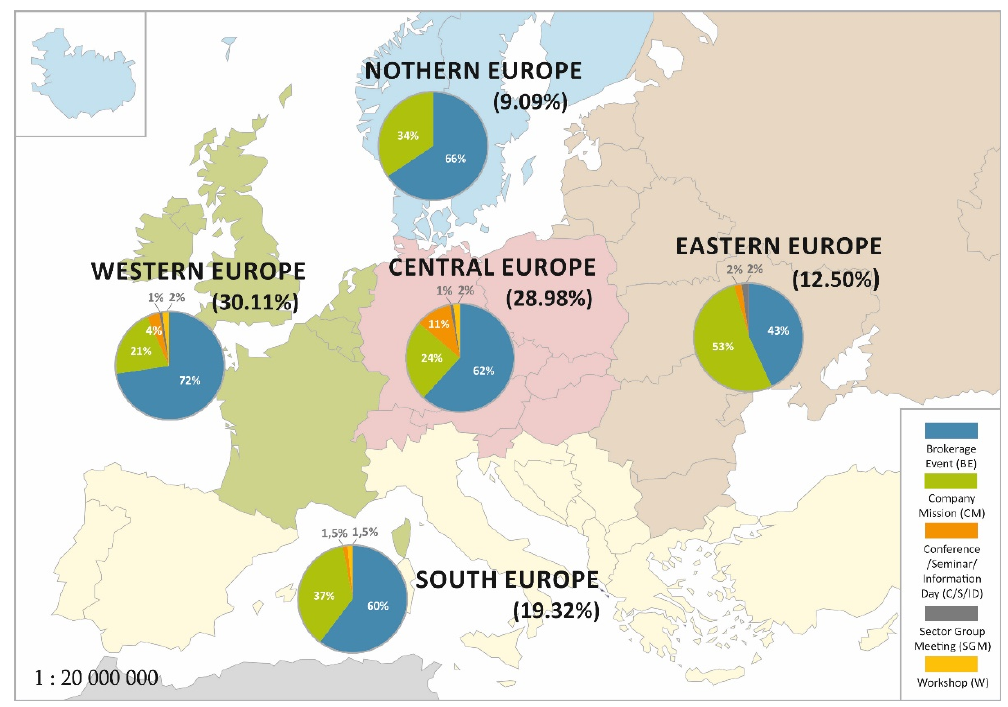
Figure 3. Structure of EEN events in 2017–2018 for selected regions of Europe.